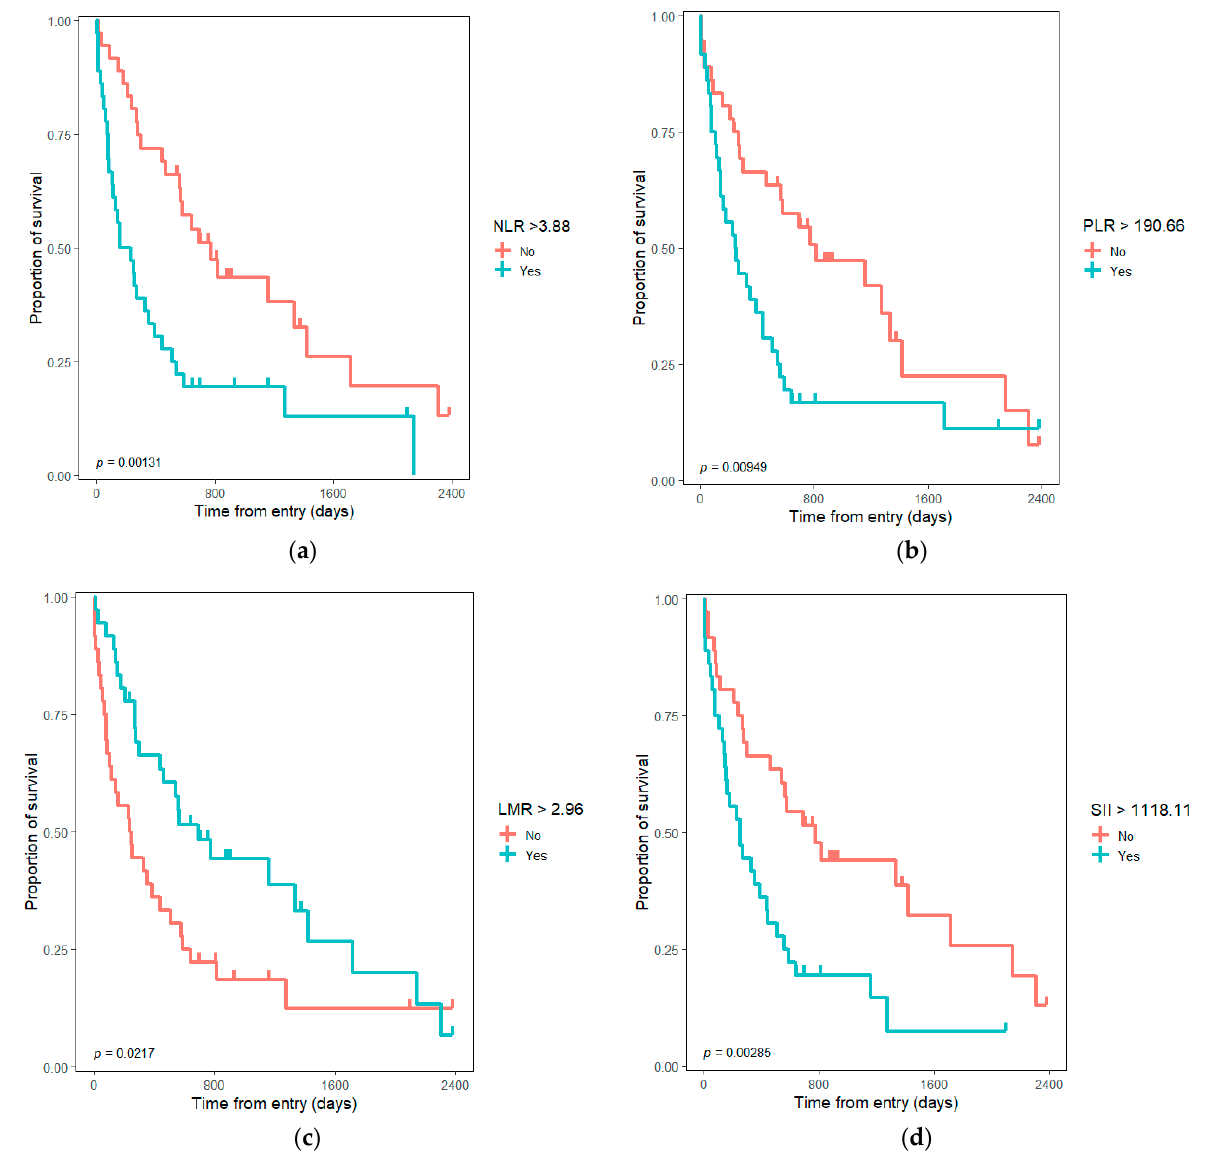
Figure 3. Kaplan–Meyer graph with survival differences for Klatskin tumors considering median value for inflammatory ratios: ( a ) survival considering NLR > median value; ( b ) survival considering PLR > median value; ( c ) survival considering LMR > median value; ( d ) survival considering SII > median value. NLR—neutrophil to lymphocyte ratio; PLR—platelet to lymphocyte ratio; LMR— lymphocyte to monocyte ratio; SII—systemic immune-inflammation index.